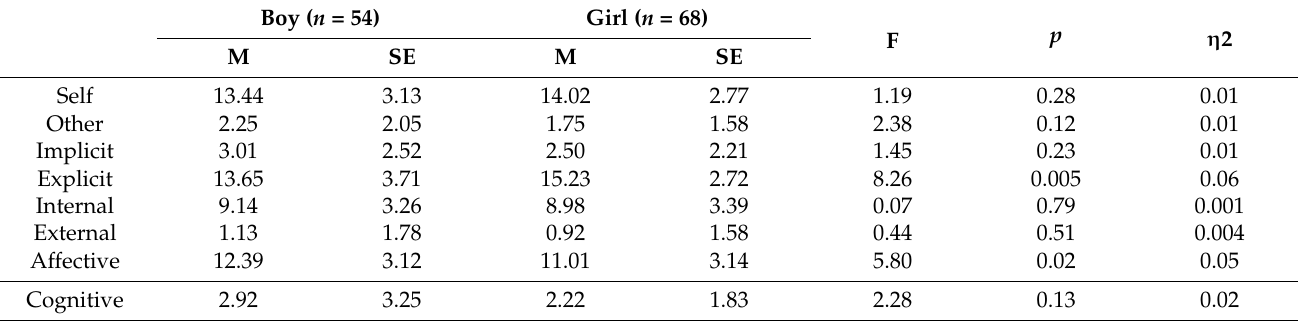
Table 4. Means, Standard Deviations, and sex Differences in CRF